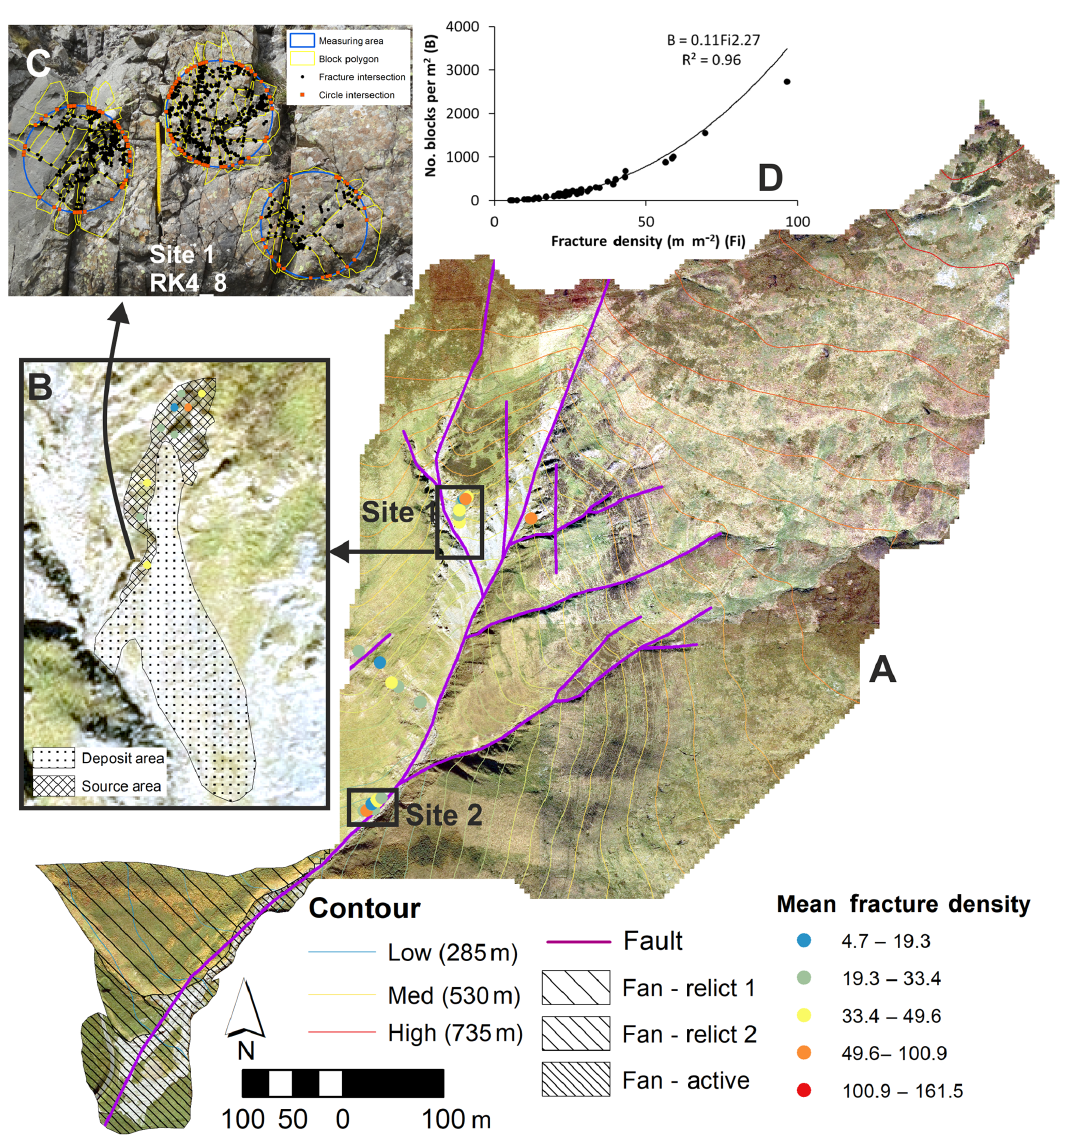
Figure 5. Multi-scalar fracture network and block-size analysis for the Codleteith Burn catchment in the Southern Uplands of Scotland (a) . Sites 1 (b) and 2 (not shown) are sub-catchment hillslope source areas sampled at high resolution. Variability at the outcrop scale was captured using multiple sampling windows per image (c) . The number of blocks sampled per square metre is strongly related to the fracture density (d)